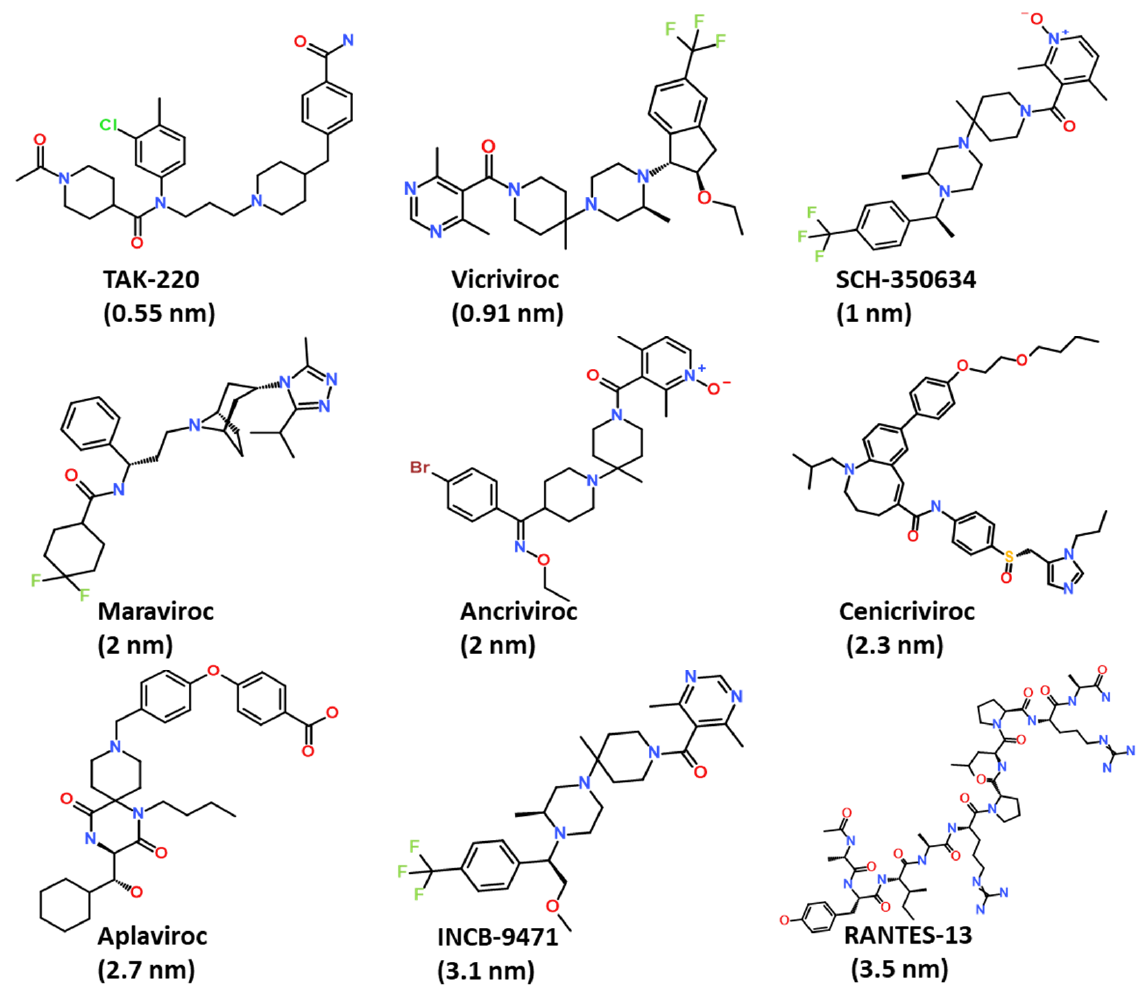
Figure 2. The 2D chemical structures of compounds used for the generation of the common feature pharmacophore model. Table 1. Chemical features of generated hypothesis by using the Hip-Hop algorithm. Sr.